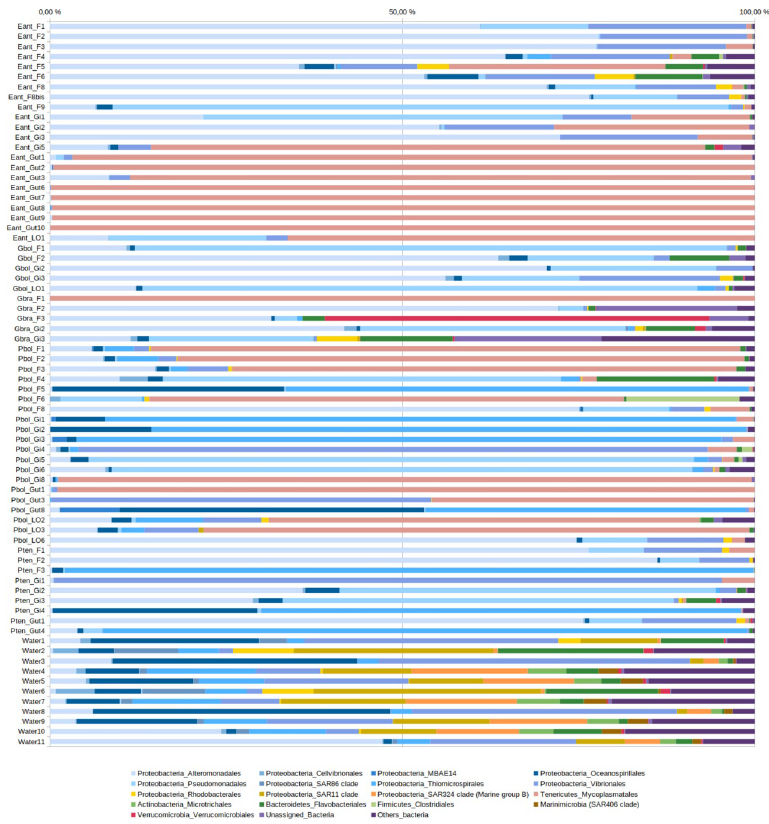
Fig 2. Relative abundances of the different bacterial orders in libraries obtained from the different samples. See Table 1 for nomenclature. Gammaproteobacterial orders are displayed as different shades of blue, alphaproteobacterial orders in shades of yellow. Bacterial orders that are below 3% in all samples are grouped under “Other bacteria”.